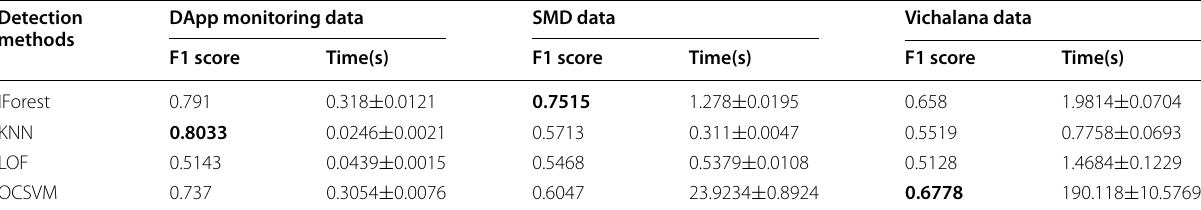
Table 4 Performance of different detection methods on three datasets. For each dataset, the F1 score of the best detection method is shown in bold Detection